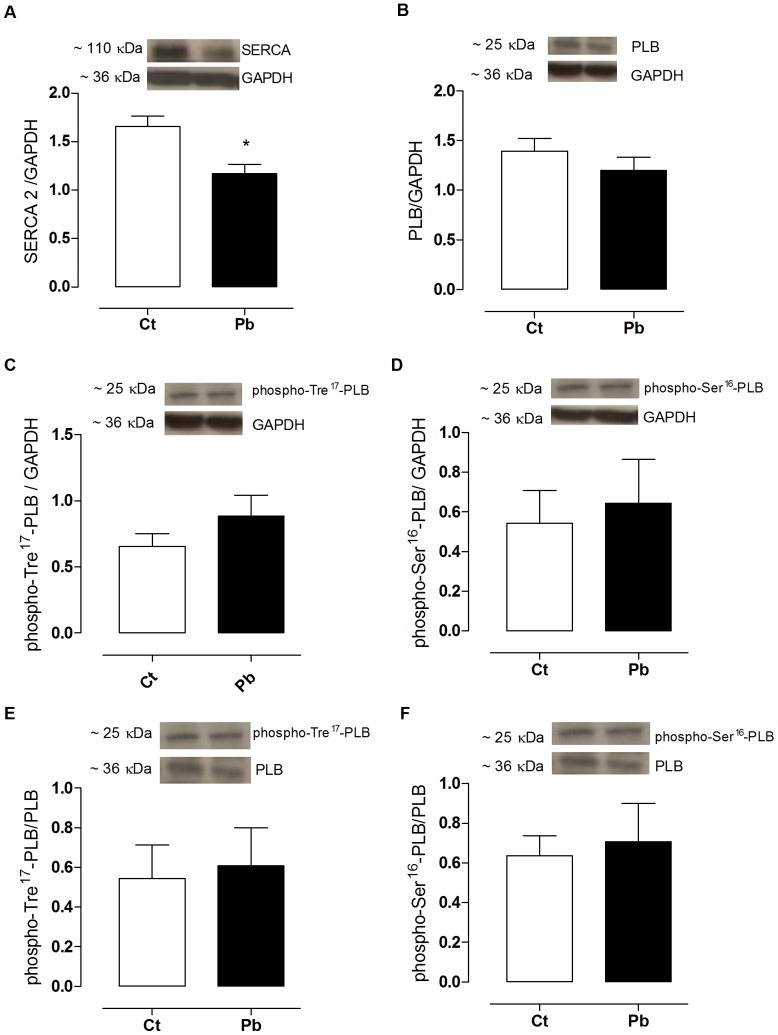
Protein expression levels of the ventricular calcium pump SR (SERCA 2), phospholamban (PLB), phospho-Tre17-PLB, phospho-Ser16-PLB, as well as the ratios phospho-Tre17-PLB/PLB and phospho-Ser16-PLB/PLB from controls (Ct) and lead treated (Pb) groups.Bands are representative of the Western blots of the expression of SERCA-2, PLB, phospho-Tre17-PLB, phospho-Ser16-PLB and GAPDH (Glyceraldehyde 3-phosphate dehydrogenase) are presented at the top of the figure. The results are expressed as the ratio between the area and density of SERCA-2 or PLB and GAPDH in the Ct- and Pb-groups. Number of animals = 7 for each group.*p<0.05, Ct vs Pb, Student t-test.